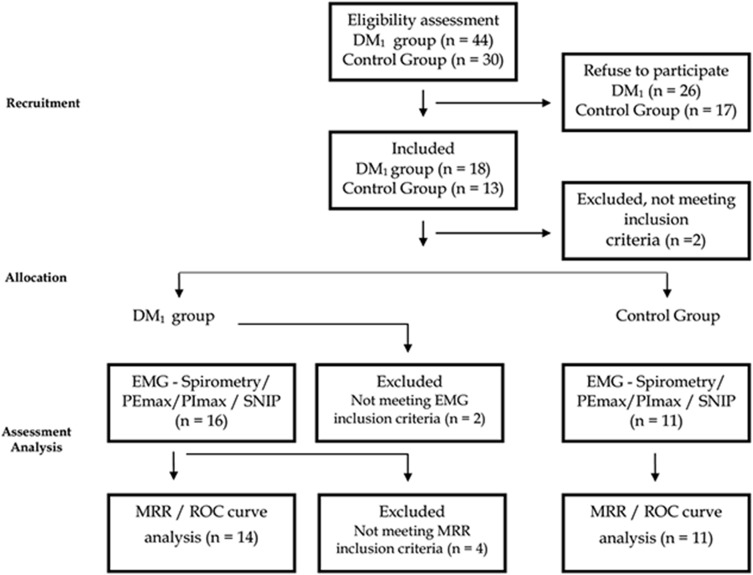
Study flowchart.